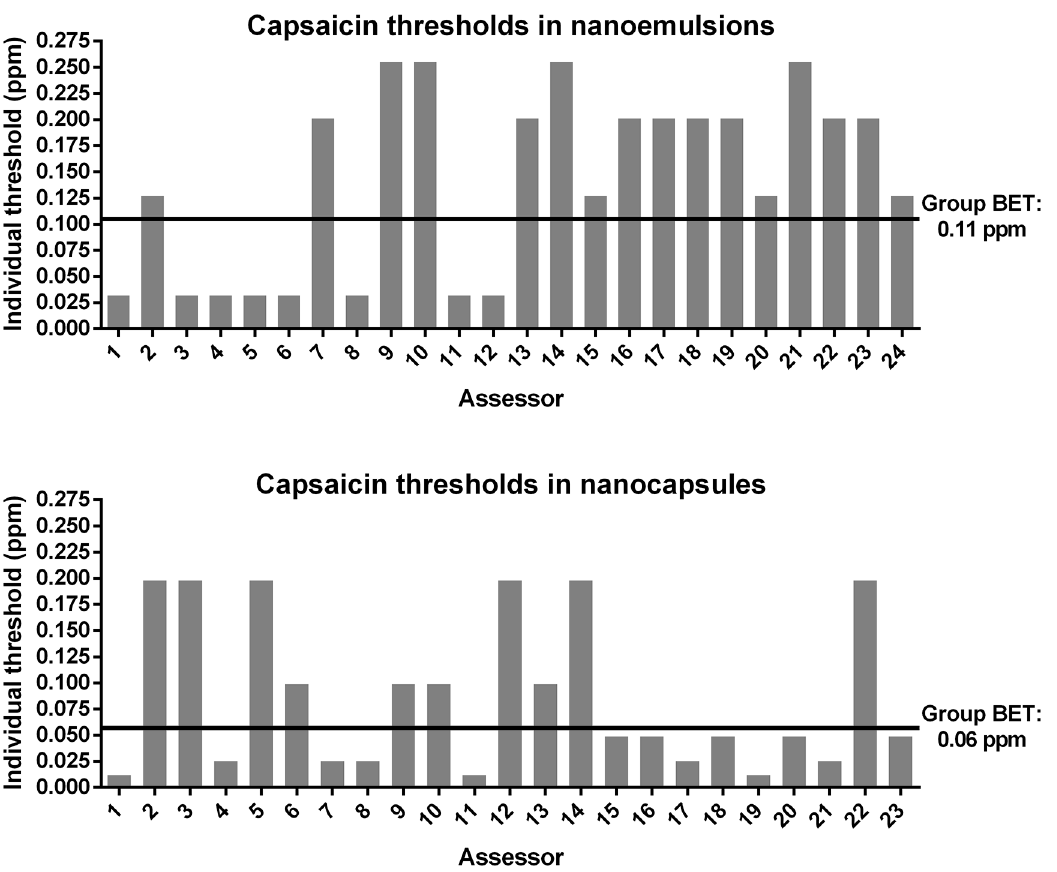
Fig 5. Individual best estimate threshold (BET) of capsaicin-loaded nanoformulations. Individual BET of each panelist in comparison to the group BET for the capsaicin-loaded nanoemulsion and nanocapsules.